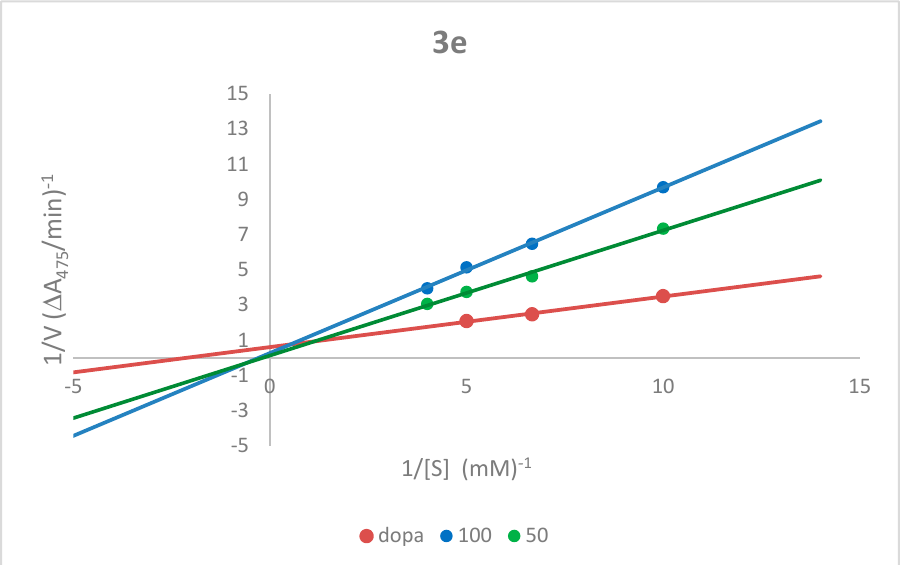
Figure 8. Lineweaver-Burk plots for tyrosinase inhibition for compounds 3e at concentration 200 µM using L-DOPA as substrate at concentrations 100, 150, 200 and 250 µM.